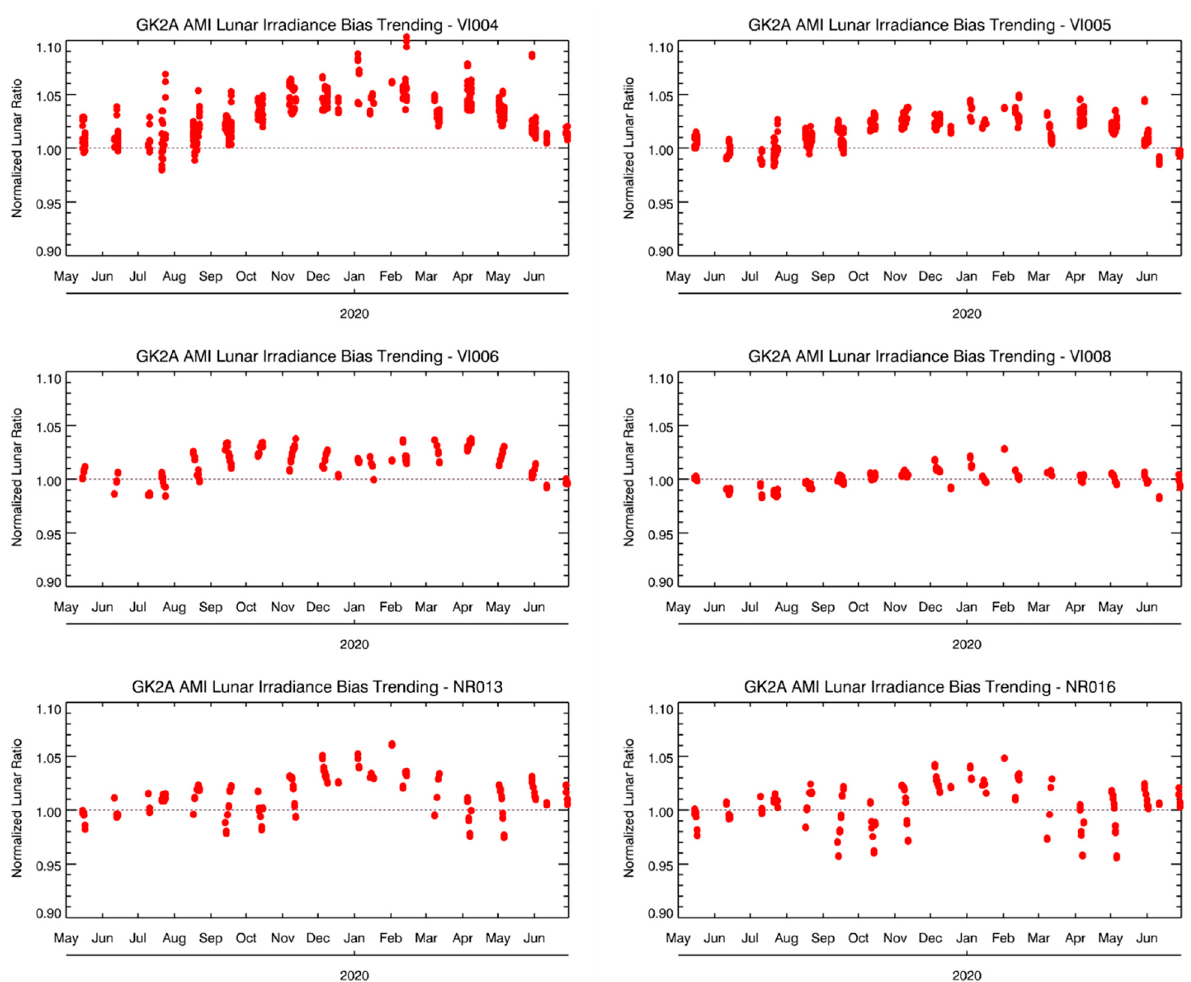
Figure 8. Lunar irradiance bias trending of AMI visible and near-infrared (VNIR) channels from May 2019 to June 2020.